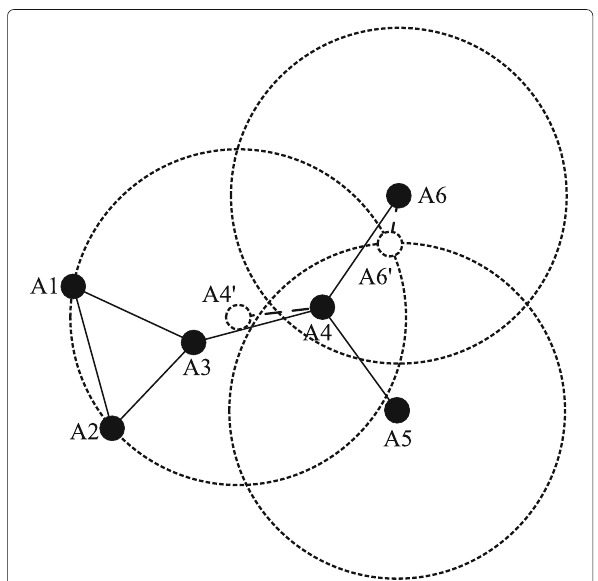
Fig. 7 The maximum distance a node travels in HCR